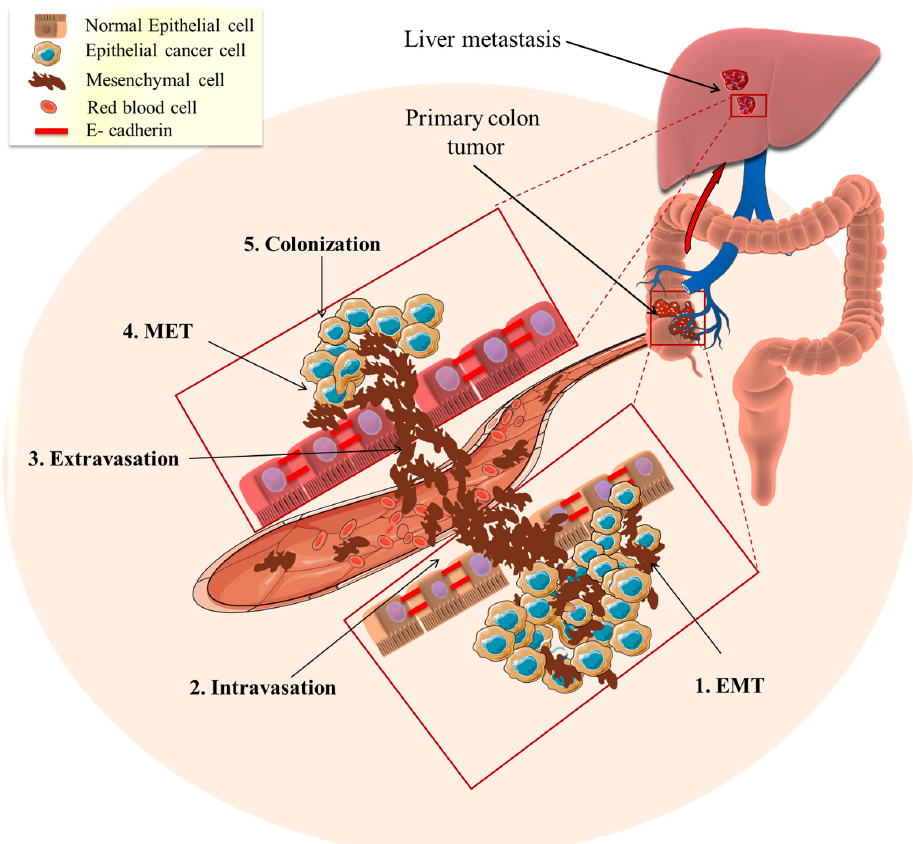
Figure 2. Epithelial to mesenchymal transition (EMT) role in cancer metastasis. The tumor epithelial cells transform mesenchymal invasive cells through EMT (1. EMT). Subsequently, the mesenchymal cells enter the blood circulation to distant places (2. Intravasation) and this results in the homing of circulating tumor cells to specific organs or tissues (3. Extravasation). The metastasized mesenchymal cells transition to the epithelial phenotype through the mesenchymal–epithelial transition (4. MET). The MET-transformed cancer cells become implanted and interact to form new colonies (5. Colonization) and ultimately forming a tumor.